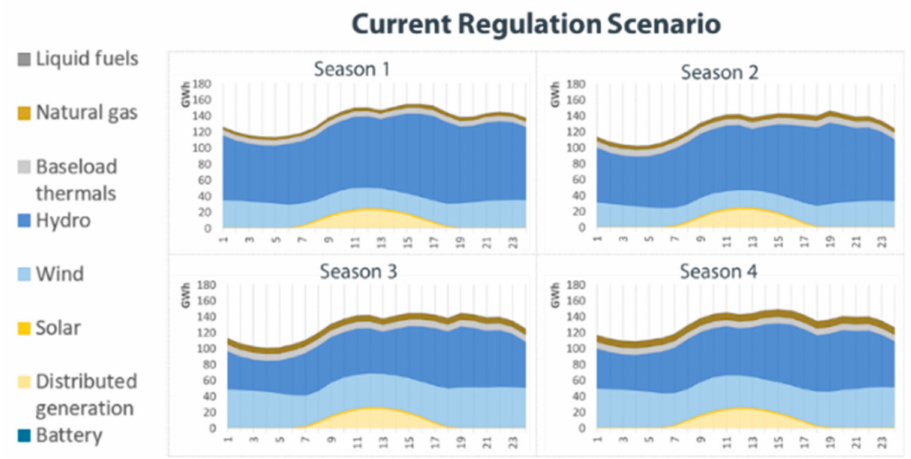
Figure 12. Generation profile per season in the current regulation scenario.